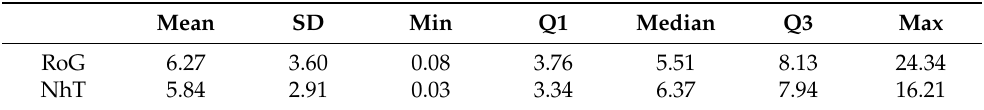
Table 2. The summary statistics of a total of 2013 study participants’ travel patterns quantified by the Radius of Gyration (RoG) and Non-home Time (NhT).